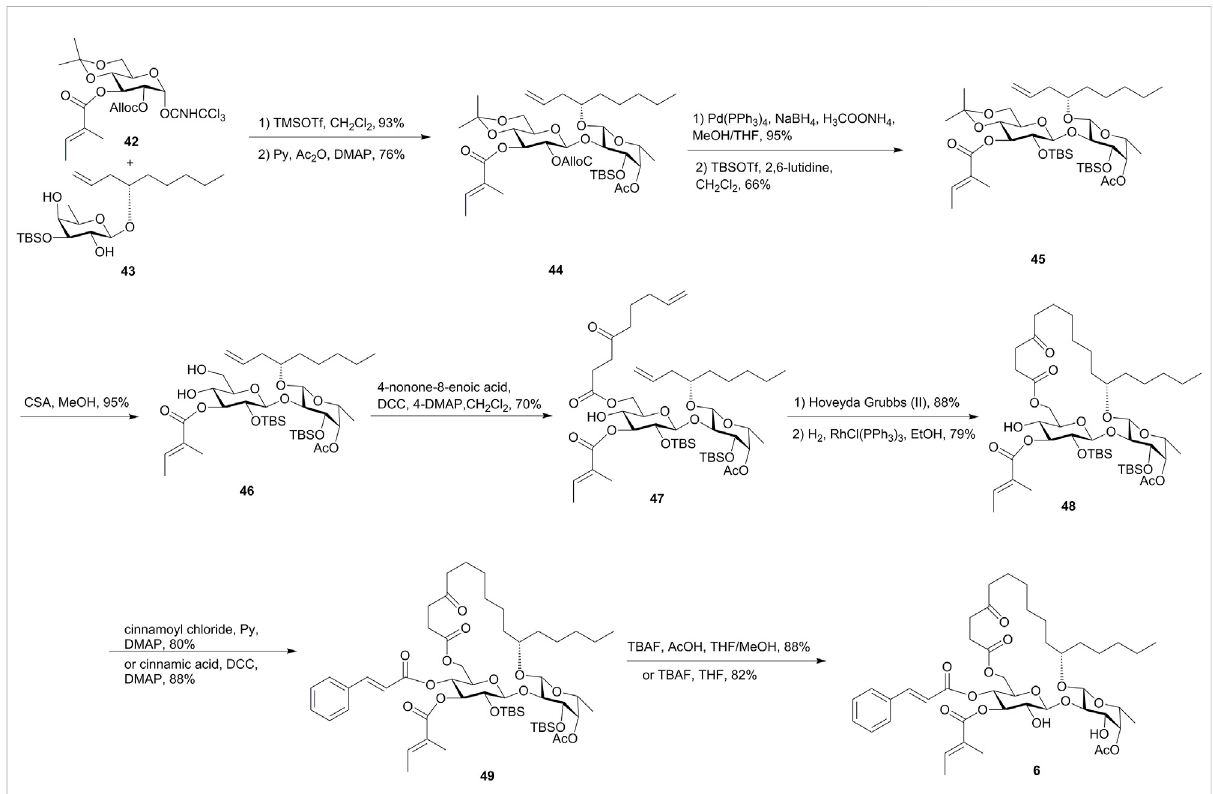
FIGURE 5 First Shi ’ s approach toward the synthesis of ipomoeassin F ( 6 ). Alloc, allyloxycarbonyl; CSA, camphor-10-sulfonic